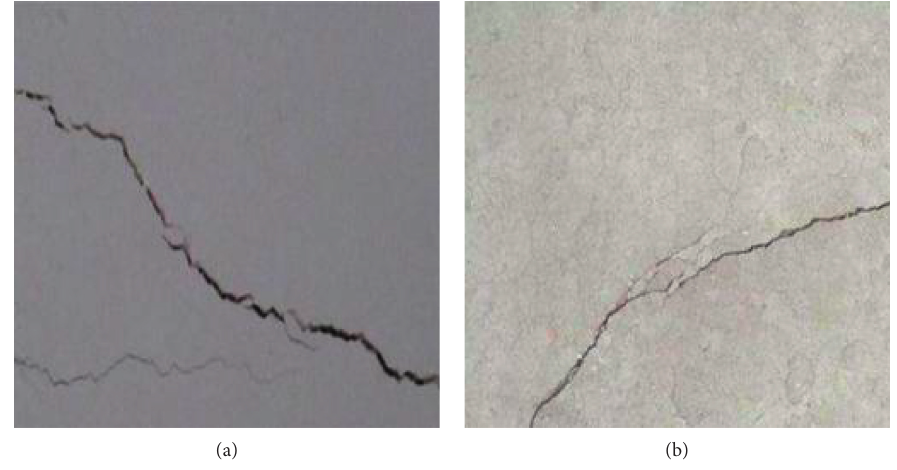
Figure 21: Original images: (a) crack 1; (b) crack